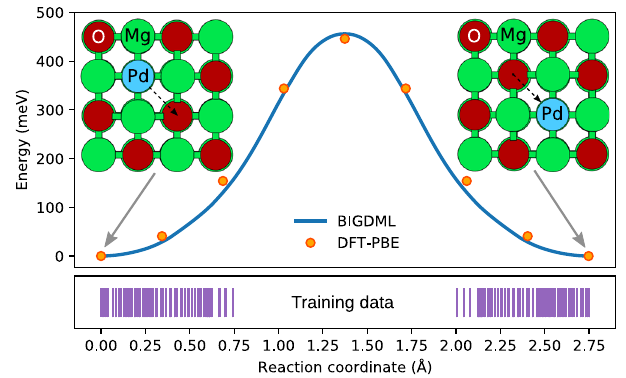
Fig. 5 Model performance on unseen energy barriers. Comparison of the minimum-energy path between neighbouring oxygen-sites for a single Pd supported on a MgO (100) surface using BIGDML (continuous line) and the reference method, DFT/PBE (circles). The purple lines indicate the location of the Pd atom in the